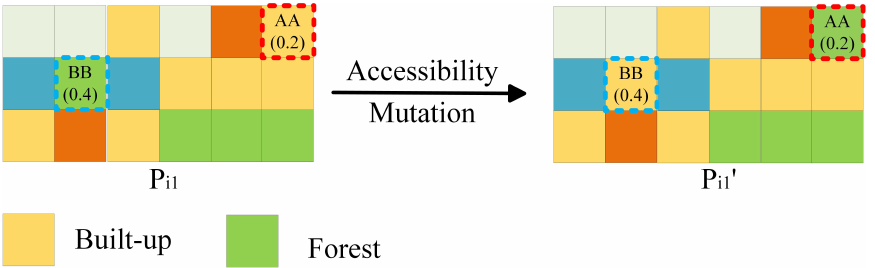
Figure 5. Schematic illustration of the procedure for crossover: replacing the center cell in Parent1 if the new center cell type in Parent2 results in neighbors of the same class that outnumbers those in Parent1.